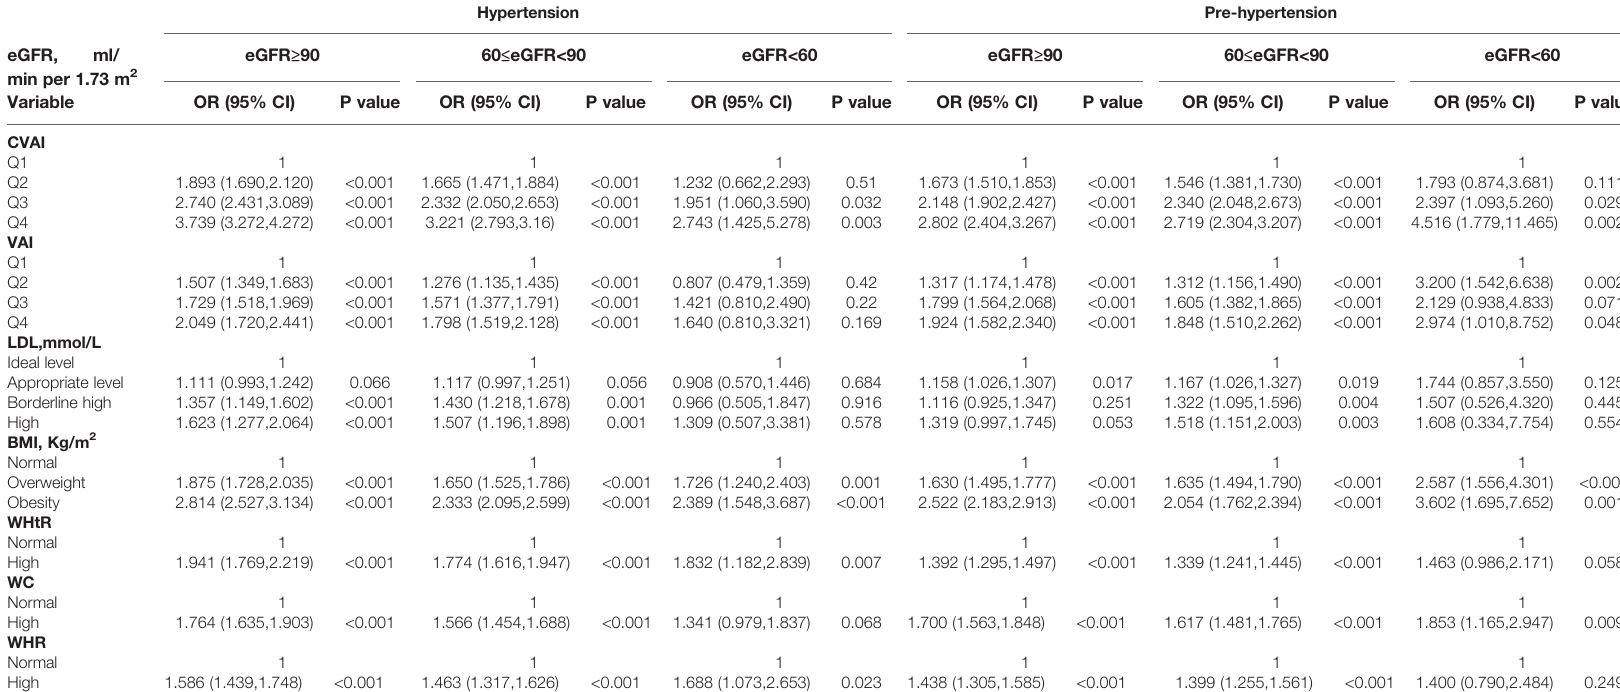
TABLE 6 | Association of CVAI, VAI, BMI, WC, WHtR, WHR and LDL-C with hypertension and prehypertension by